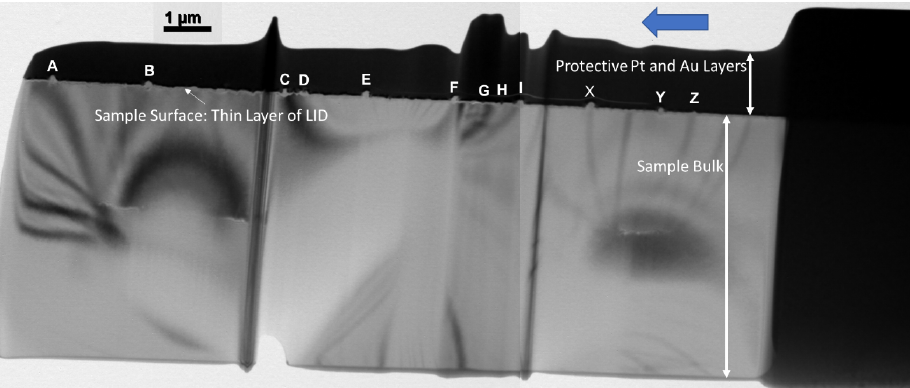
Figure 9. Cross-sectional TEM of a single, multi-shot LID site on silicon (111) with 500 shots, p -polarization. The sample oxide layer was etched 8 min prior to being shot by a train of pulses with an average fluence of 547 mJ/cm 2 . The large blue arrow points from the peripheral of the LID spot towards the center. This sample has undergone FIB processing as described in the Methods section. The letters indicate various points of interest. The different layers involved in the cross section are labeled in the figure. Additionally, a capital letter labels several areas of interest. They include raised features (NSCs or nano-spheroidal clusters) A–F,I,X,Y,Z and a few trenches